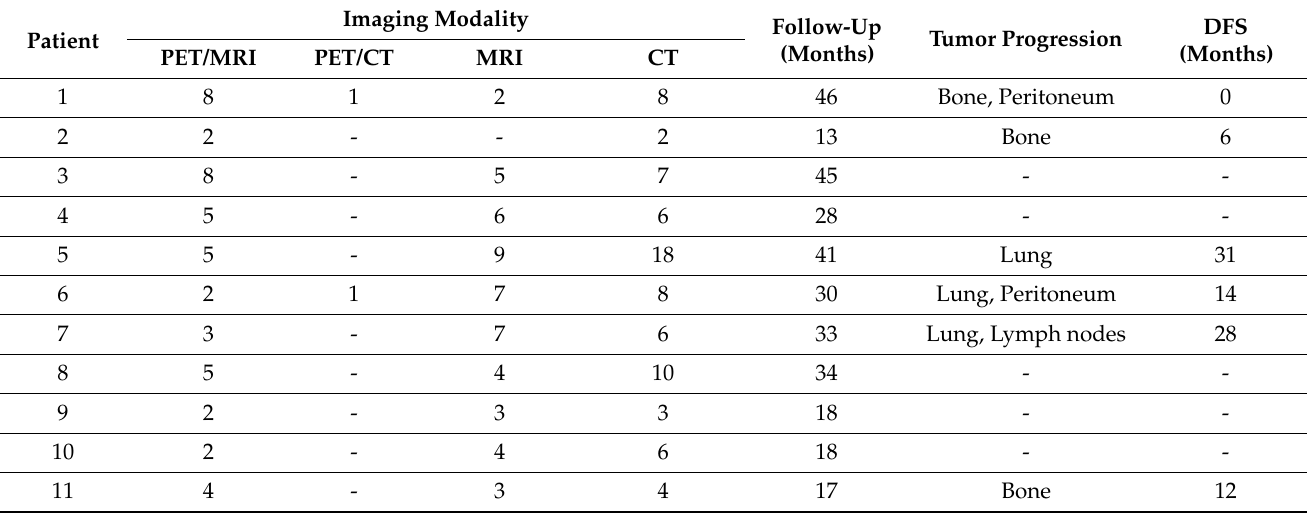
Table 1. Follow-up of the patient cohort: imaging modalities and number of scans, time period